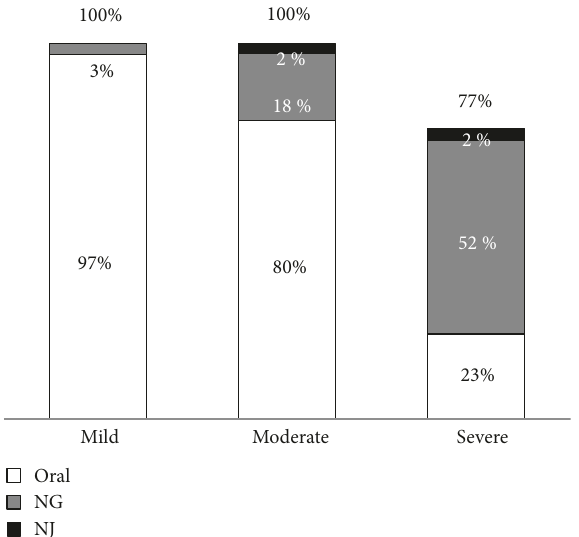
Figure 3: Routes of enteral nutrition. NG, nasogastric; NJ, nasojejunal.